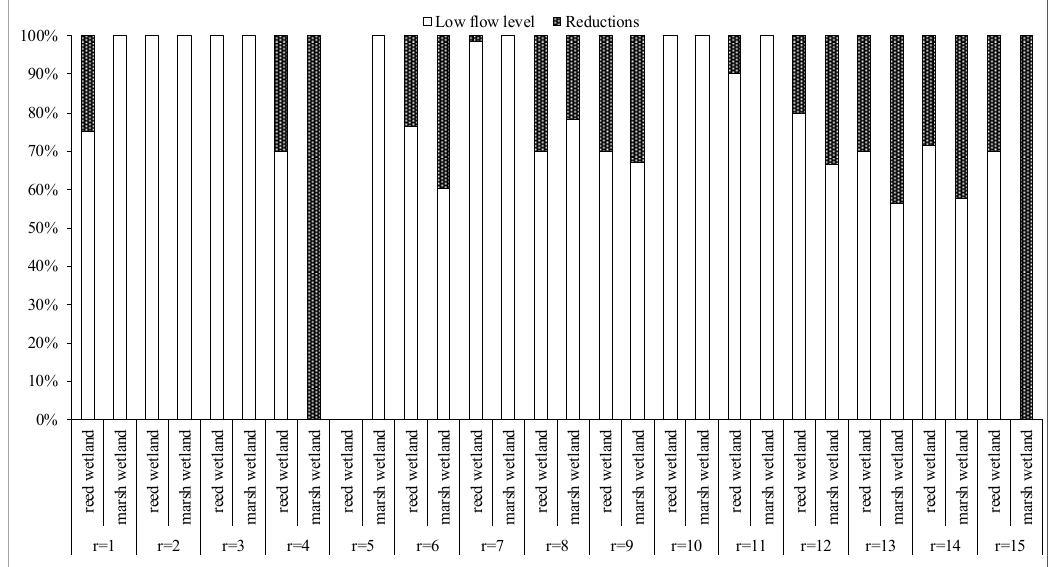
Table 5. Water diversion and ecosystem restoration schemes under low flow level in western Jilin Province. Regions